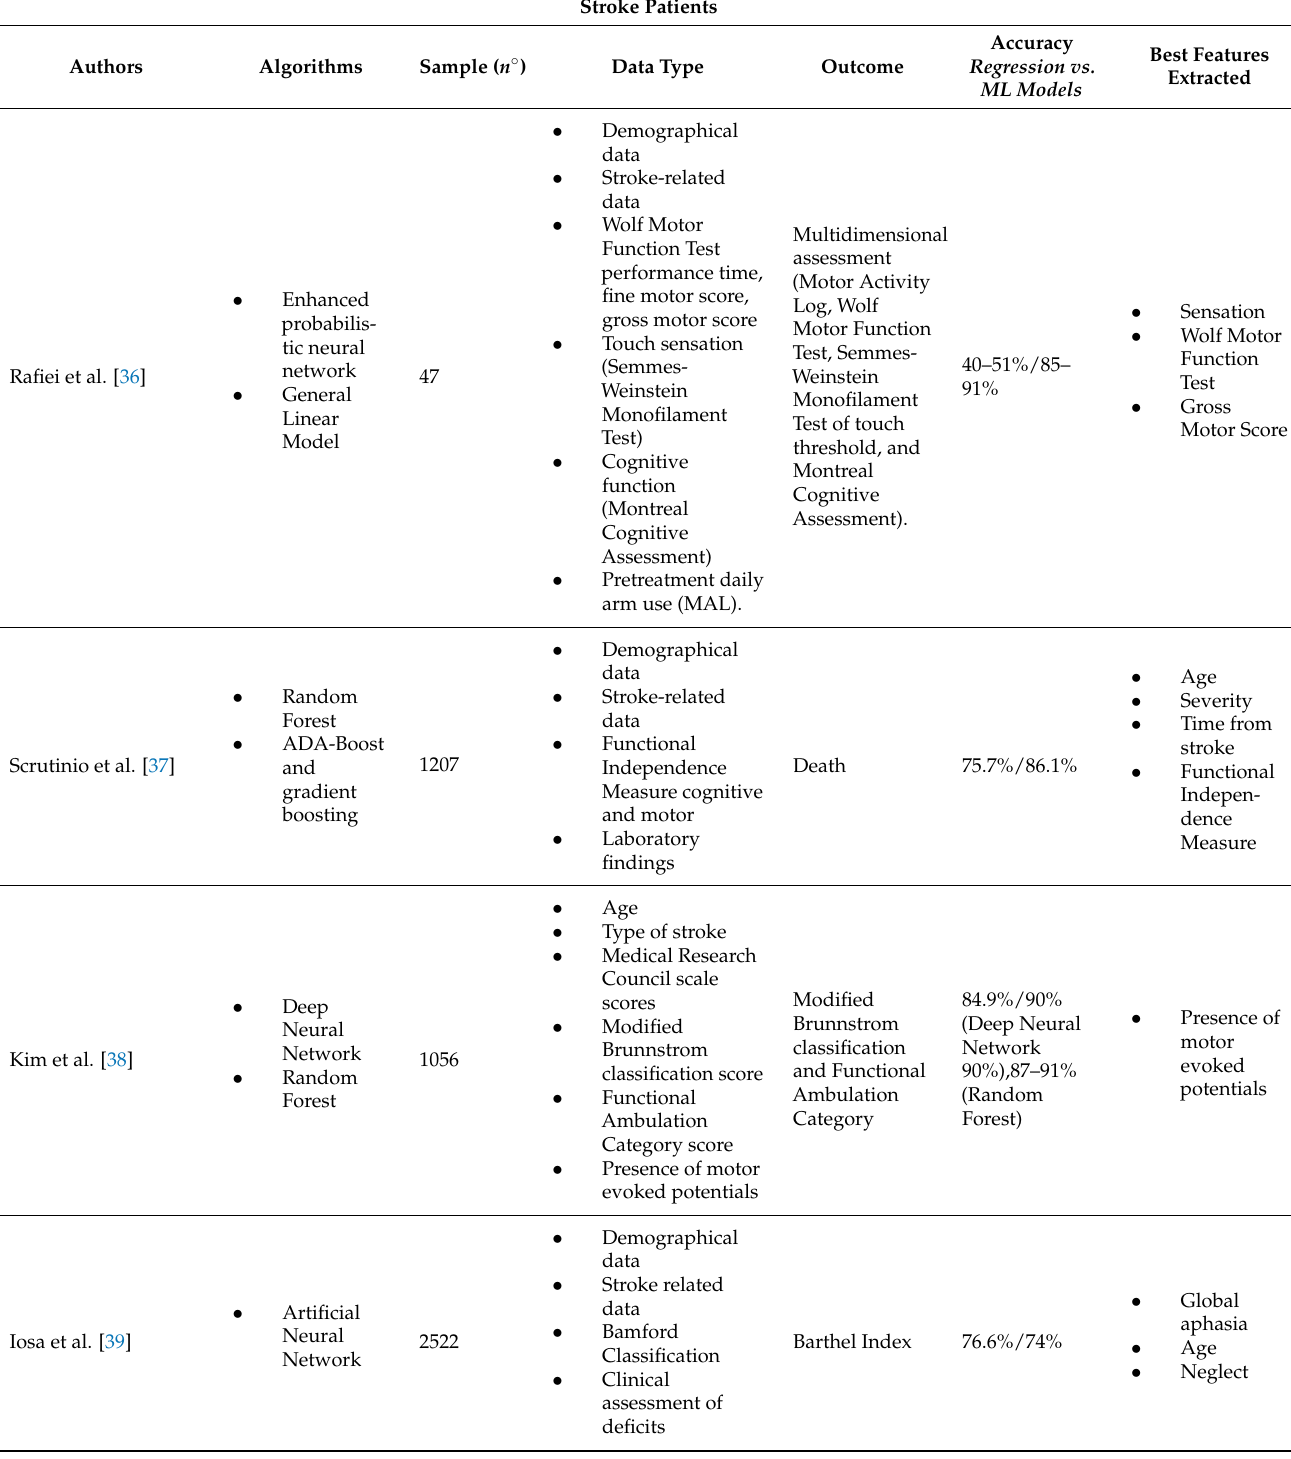
Table 3. Comparison between Machine Learning and linear regression approaches in stroke patients to predict outcome at